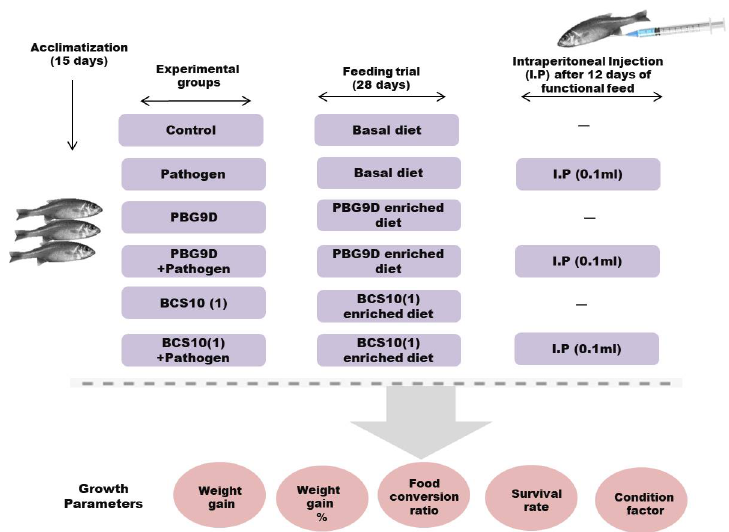
Figure 2. Schematic diagram representing experimental design for the evaluation of probiotic strains against Aeromonas hydrophila .